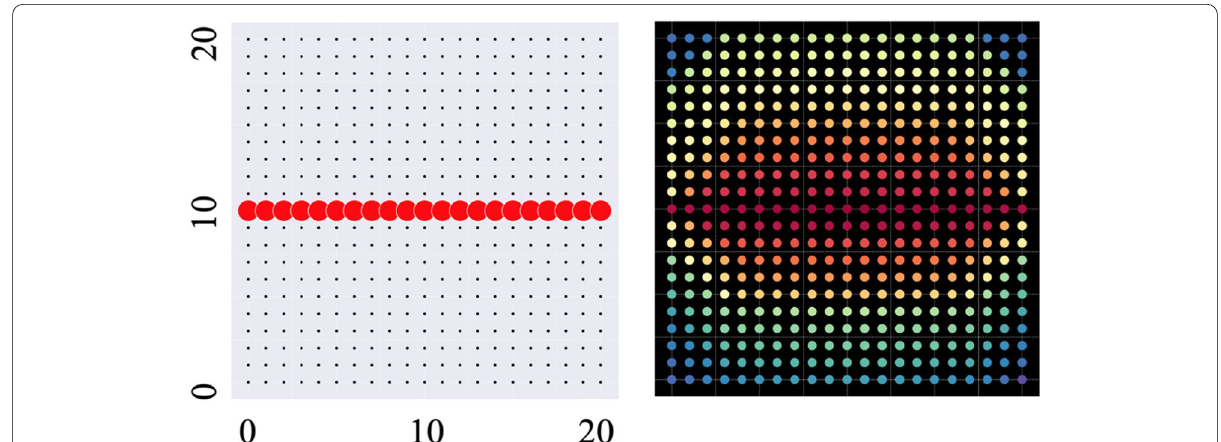
Fig. 7 Spreading the City on a Line into the Two-Dimensional Space. a) The original line left, and right b) temporal colouring, starting with the line spreading out, but retaining a measure of